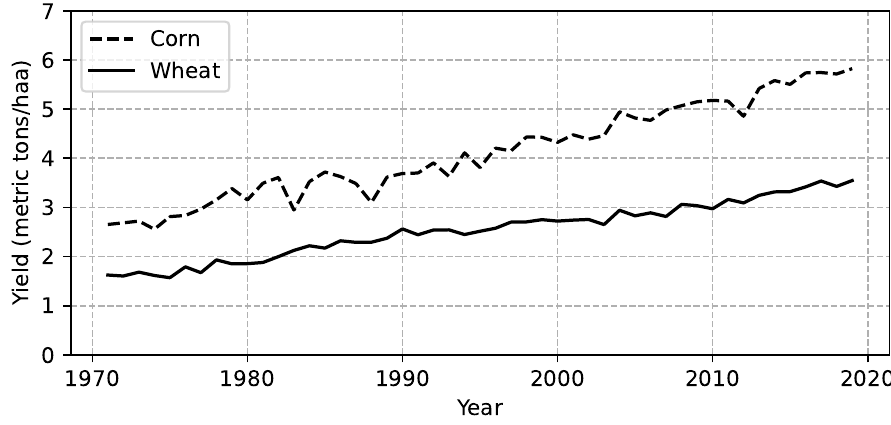
Figure 2. Annual corn and wheat yields in metric tons per ha, 1970–2019.